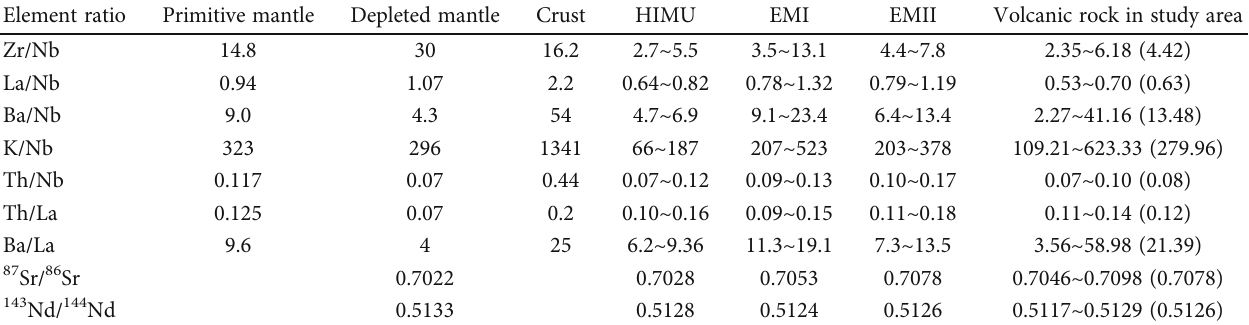
Table 4: Comparison of trace element ratios of Paleogene igneous rocks in Huimin Sag and crust and di ff erent mantle members (data of di ff erent mantle end members are from [22,